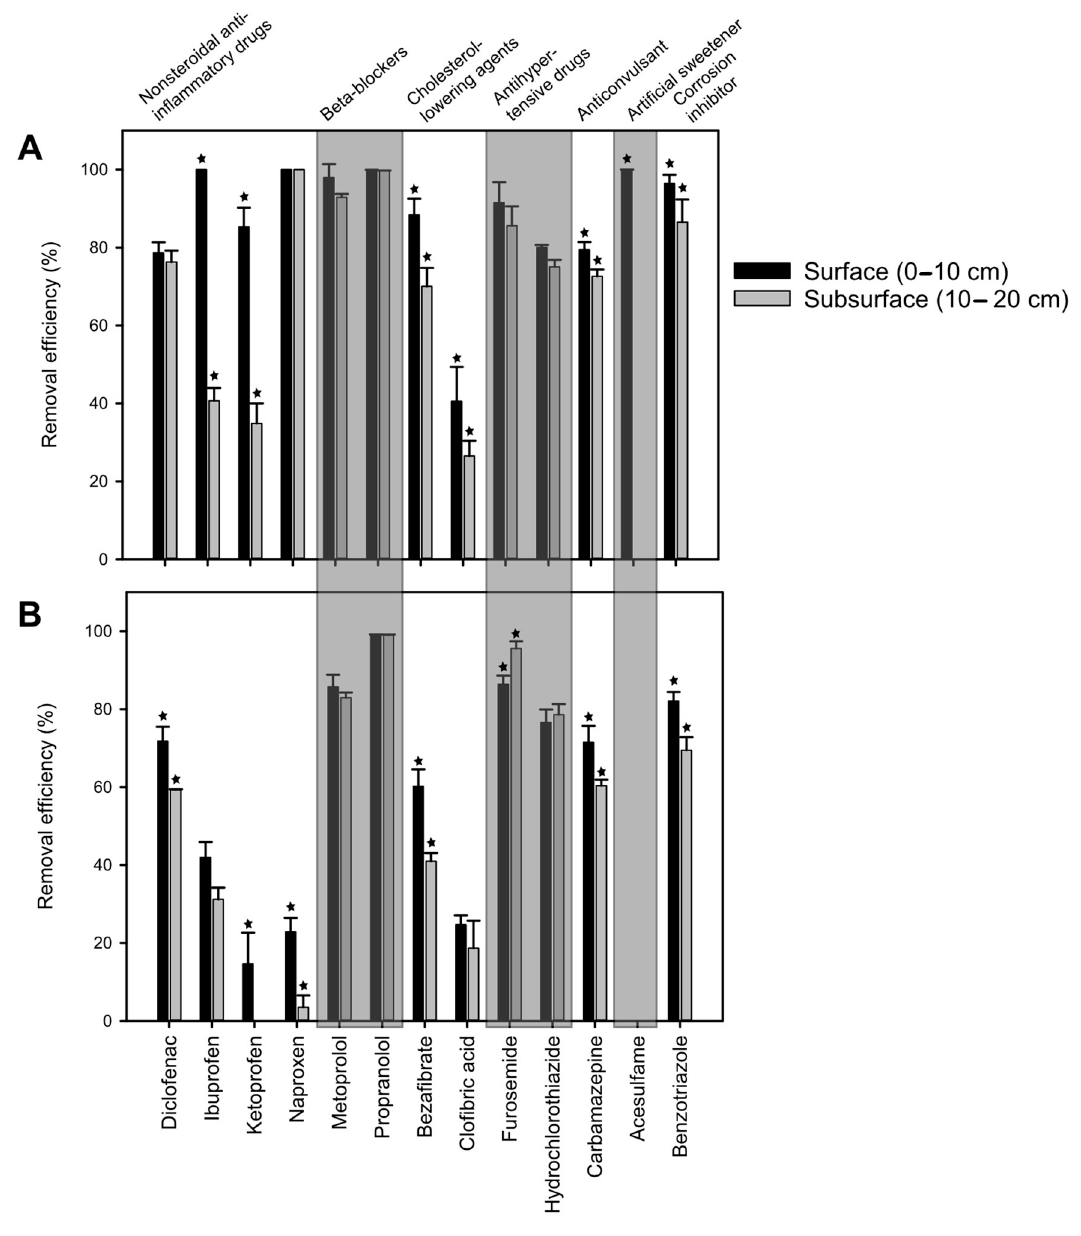
Figure 1. Relative removal e ffi ciency of test compounds in the ( A ) biotic and ( B ) abiotic (azide-inhibited, sorption) batch microcosms containing surface and subsurface sediment samples after 65 days of incubation. Values are the arithmetic means of triplicate incubations. Error bars indicate standard deviations. Some standard deviations are smaller than the symbol size and, therefore, not apparent. Asterisks (*) indicate significant di ff erences in removal e ffi ciency between surface and subsurface sediment samples (ANOVA, p < 0.05). Compound groups are indicated above panel A.